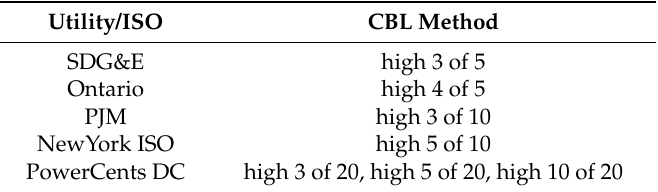
Table 1. Details for the high X of Y methods used by several utility companies and independent system operators